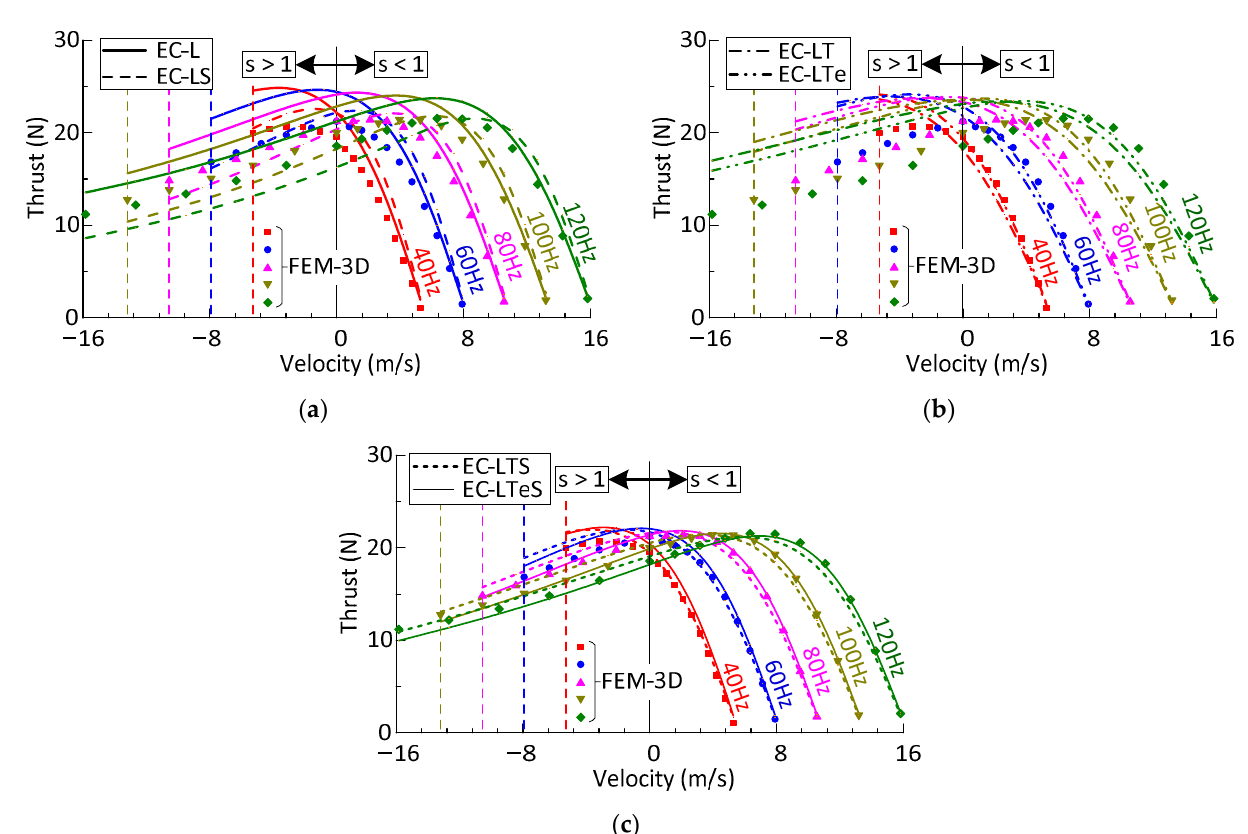
Figure 10. Thrust versus velocity characteristics at constant current calculated by FEM 3D model: ( a ) equivalent circuit EC-L and EC-LS model; ( b ) equivalent circuit EC-LT and EC-LTe model; ( c ) equivalent circuit EC-LTS and EC-LTeS model.